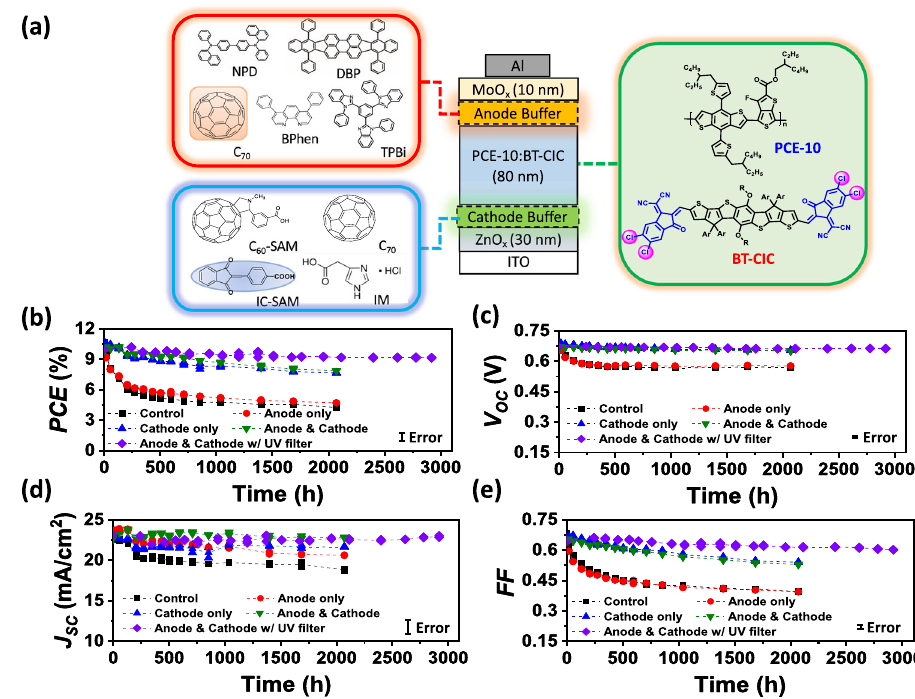
Fig. 1 Device structure, molecular structures, and OPV ageing data under 1 sun simulated AM1.5 G illumination. a Schematic of the device showing layer thicknesses and compositions (right): molecular structural formulae of the PCE-10 and BT-CIC (left): molecular structural formulae of the cathode and anode buffer materials. b PCE power conversion ef fi ciency, c V OC Open-circuit voltage, d J SC Short circuit current, and e FF Fill factor, plotted vs. aging time under 1 sun simulated AM1.5 G illumination for 3000 h with different device architectures (populations of 3 – 4 devices). The error bars indicate the 1 s.d. uncertainty of each measurement.